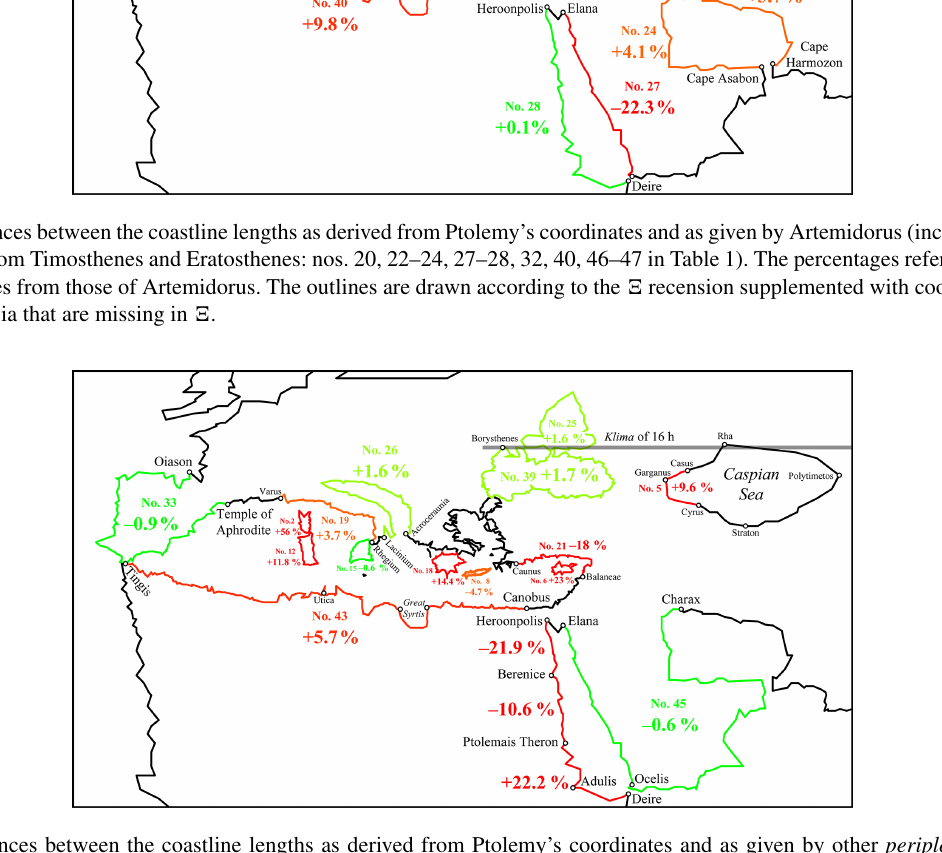
Figure 3. Differences between the coastline lengths as derived from Ptolemy’s coordinates and as given by other periploi -based sources (nos. 2, 5–6, 8, 12, 16–19, 21, 25, 28, 33, 39, 43–44 in Table 1). The percentages refer to the deviation of Ptolemy’s values from those of other sources. The outlines are drawn according to the (cid:52) recension supplemented with coordinates from (cid:127) for the areas of Asia that are missing in (cid:52)